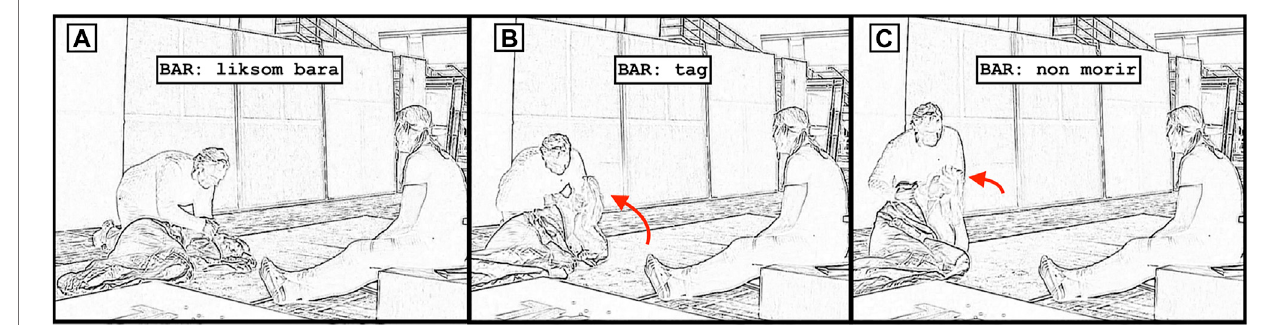
FIGURE 3 | The baritone suspends syntax as he undertakes to lift the soprano.